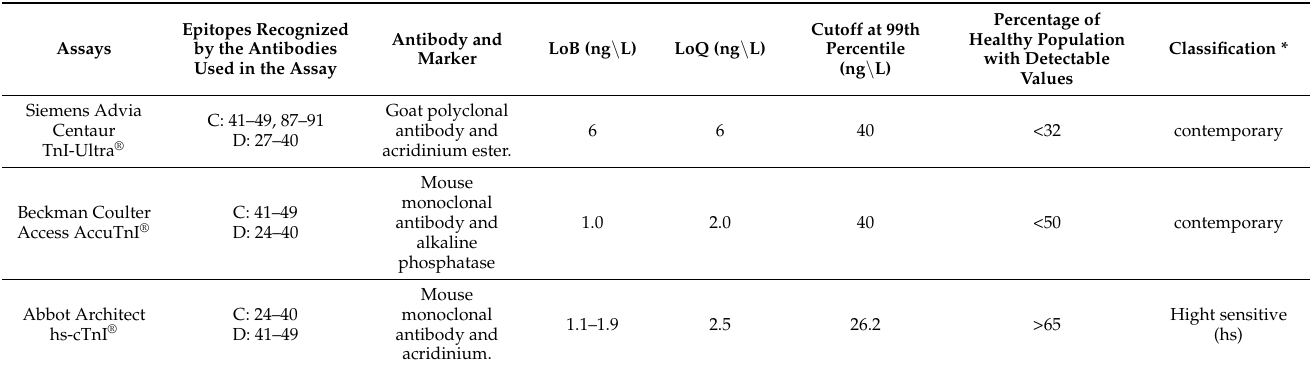
Table 1. Biochemical and analytical performance differences between the troponin assays used in the study.